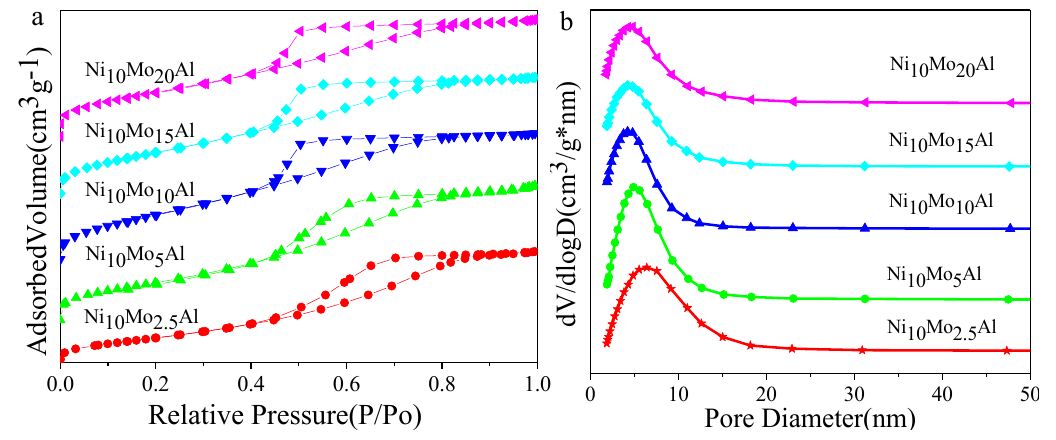
Figure 5. The N 2 adsorption − desorption isotherms ( a ) and the distributions of pore size ( b ) of Figure 4. The N 2 adsorption–desorption isotherms ( a ) and the distributions of pore size ( b ) of Ni 10 Mo x Al catalysts. Ni 10 Mo x Al catalysts.